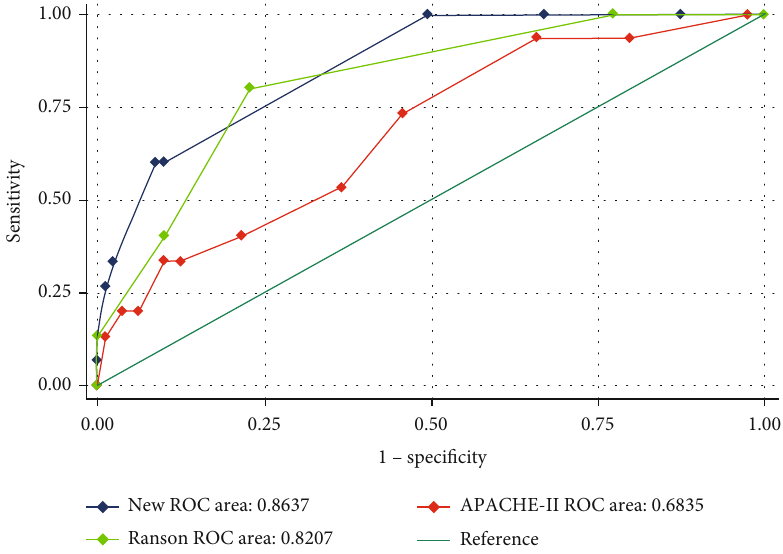
Figure 2: Comparisons of the AUCs between scoring systems in prediction of